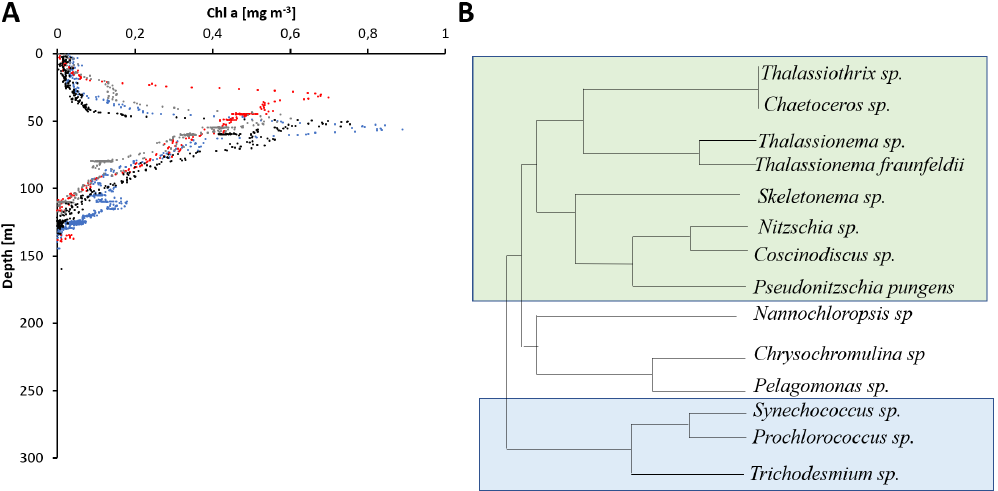
Figure 2. (a) Vertical profiles of chlorophyll a from four stations in the open ocean region of the BoB taken from Löscher et al. (2020). (b) Schematic depiction of the phylogenetic diversity of primary producers identified in the BoB: green box: diatoms; blue box: cyanobacte-